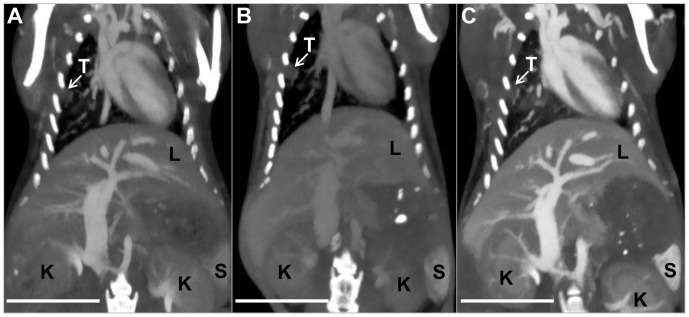
Thick slab maximum intensity projections of the 80 kVp CT datasets following bilateral filtration.CT scan 1 is shown in (A), CT scan 2 in (B) and CT scan 3 in (C). Tumor is marked “T,” liver is marked “L,” spleen is marked “S.” and kidneys are marked “K.” The images are all windowed between −300 and 1200 HU. The scale bar represents 1 cm in all panels.